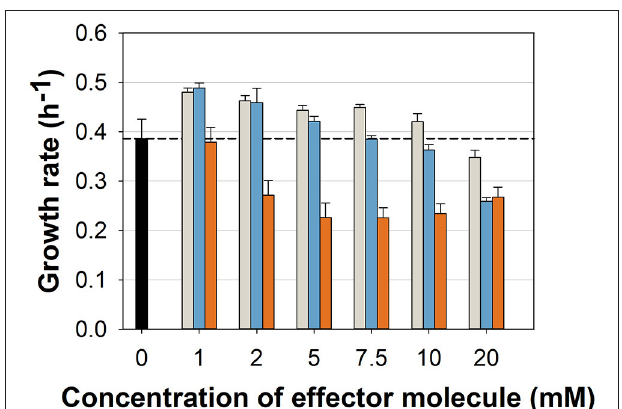
FIGURE 2 | Growth rates of C. glutamicum wild type in microliter scale cultivations with CGXII minimal medium and 20g glucose L − 1 without (black) and with different concentrations of ferulic acid (gray), vanillin (blue), and vanillic acid (orange). Black dashed line indicates mean growth rate of the wild type without any effector molecule. Growth rate was determined for all cultivations between 20 and 400 backscatter units via linear regression in a semi-logarithmic plot ( Supplementary Figure 1 ). Error bars represent standard deviation of at least three cultivations.